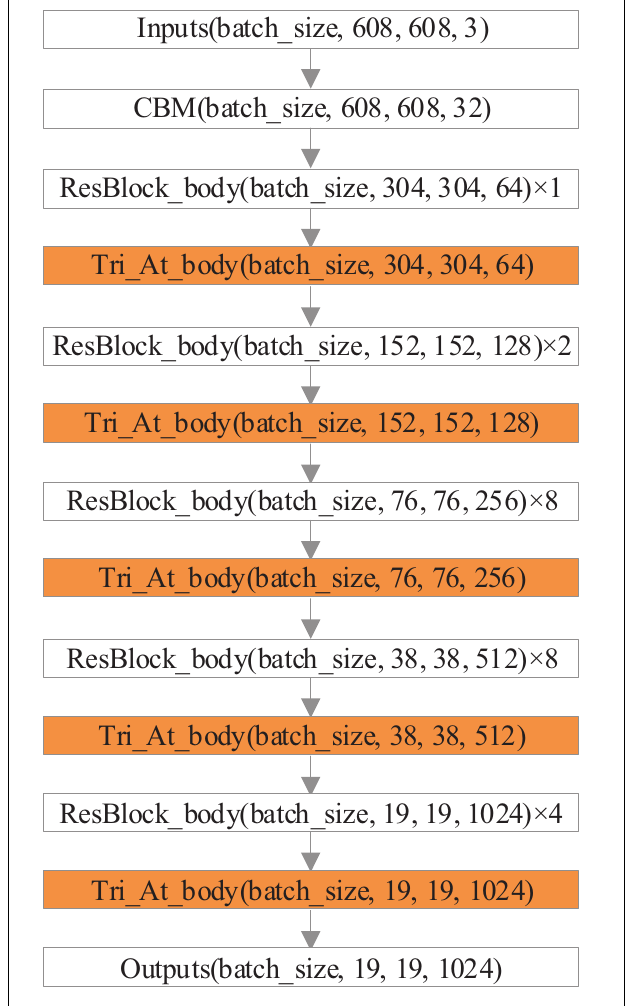
FIGURE 2 | Network structure diagram of the proposed model.